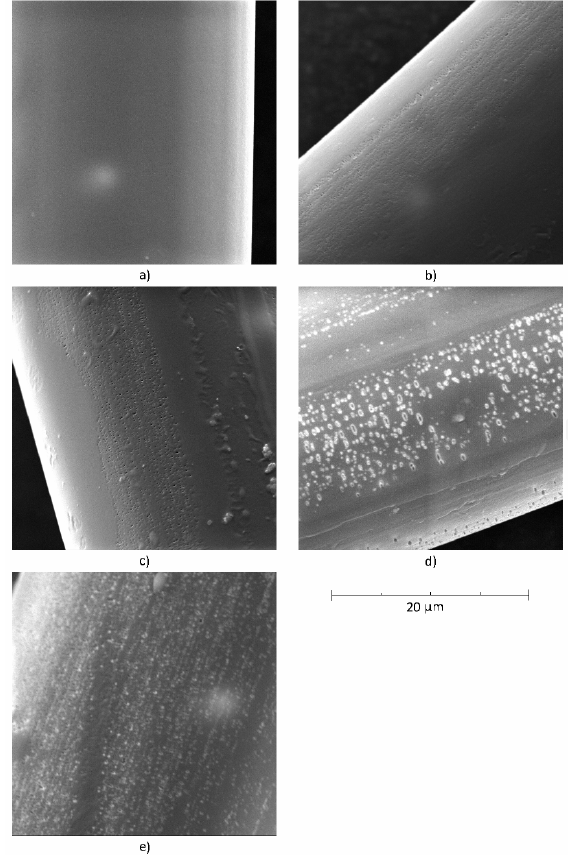
Figure 3. SEM images of treated microfibers: a) ref- erence (REF), b) O60, c) O120, d) O240, e)